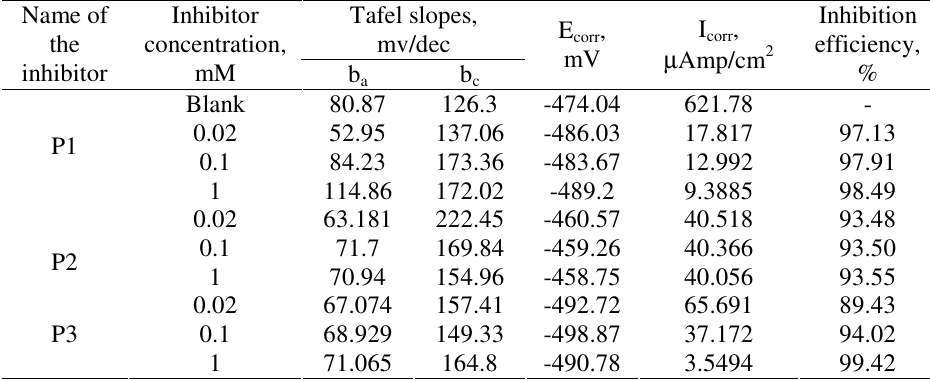
Table 4. Polarization parameters for mild steel in 1 M H concentration of the inhibitors